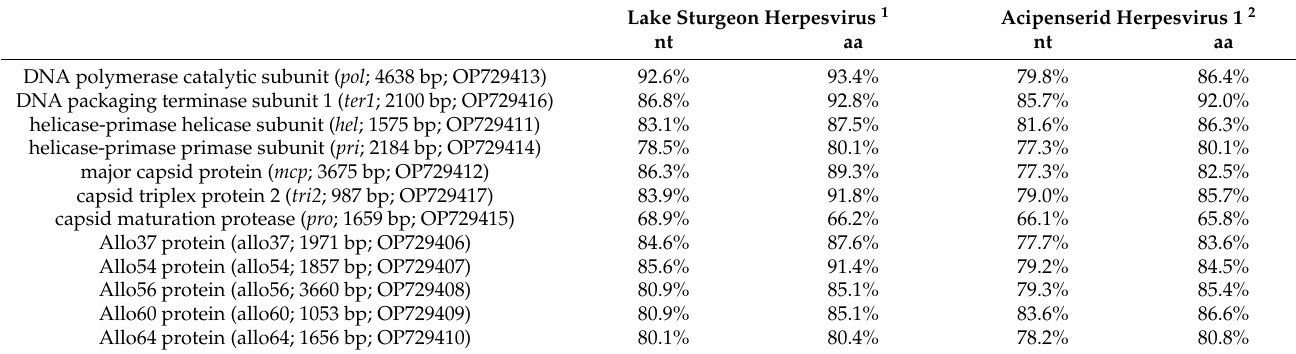
DNA polymerase catalytic subunit ( pol ; 4638 bp; OP729413)